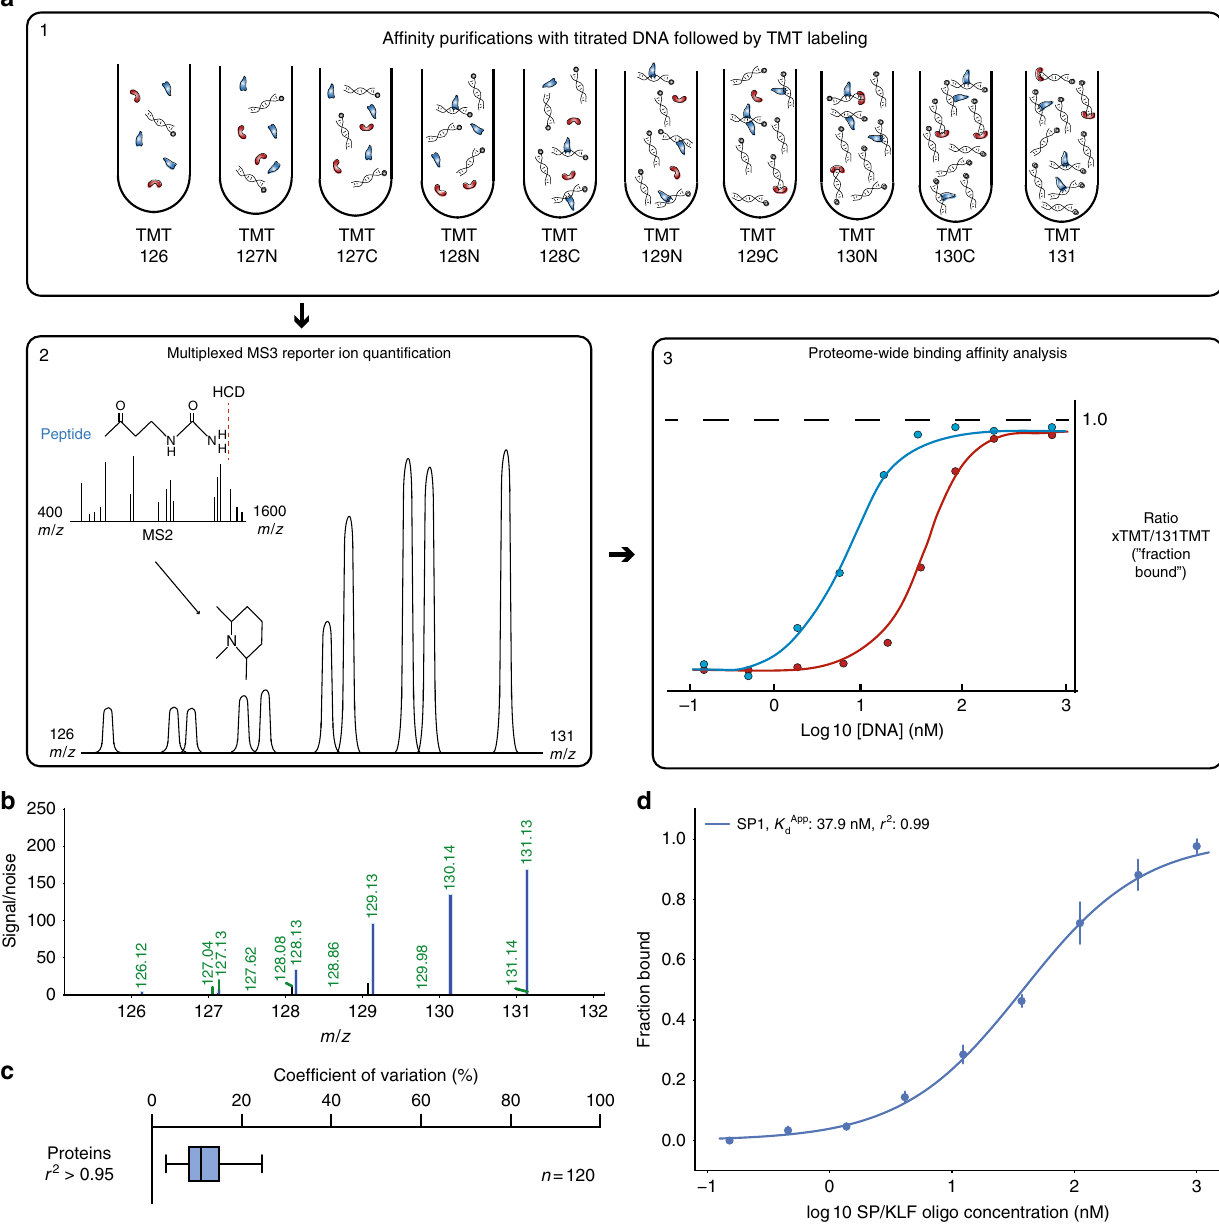
Fig. 1 Benchmarking protein – DNA K d App measurements with the SP/KLF consensus motif. a A titration series of a known concentration of bait is used for af fi nity puri fi cation of proteins from nuclear lysates. Bound proteins are digested with trypsin, isobarically labeled with TMT reagent, and analyzed by mass spectrometry. Quanti fi cation of binding interactions yields a Hill-like curve, as described in the Methods, which can be used to calculate the K d App . b SPS- MS3 TMT reporter ion spectrum of an example SP1 peptide. Only the low m / z range of the MS3 spectrum, where the TMT reporter ions are observed, is displayed for clarity. Plotted on the y -axis are signal-to-noise values measured in the orbitrap at 60,000 resolution. c Boxplot analysis of all coef fi cients of variation for fi tted K d App values identi fi ed using the SP/KLF consensus motif with r 2 values >0.95. The box represents the quartiles of the data, while the whiskers represent the range of 1.5 IQRs. The center line is the median of the distribution. d Hill-like curve identi fi ed for SP1 binding to the consensus SP/KLF GC-box motif. Binding curves were generated by fi tting the parameters of the Hill equation including K d App . Each data point is the mean of three experiments ( n = 3), and the error bars represent the standard error of the